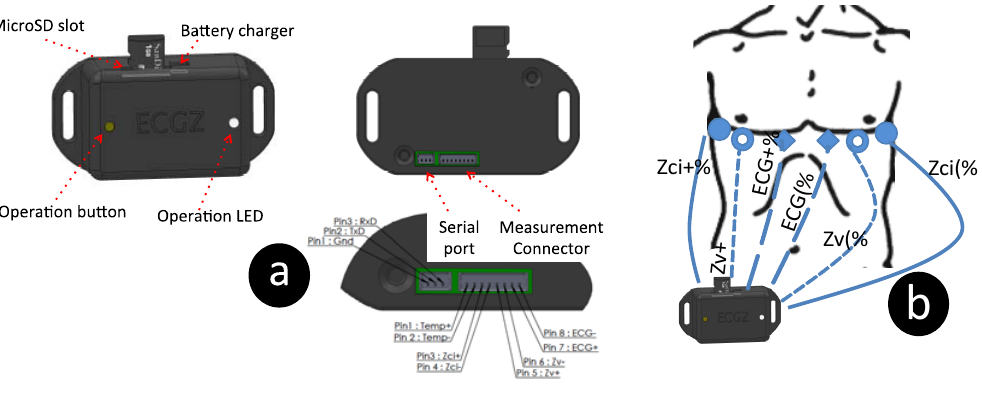
Figure 4. Drawings describing the ECG/ICG device and its connections. ( a ) Front view is on the left, back view is on the right and detail of the data and measurement connections is on the bottom. ( b ) Measuring device with a schematic connection between the ECG and the TEB electrodes placed on the torso for respiration measurements.